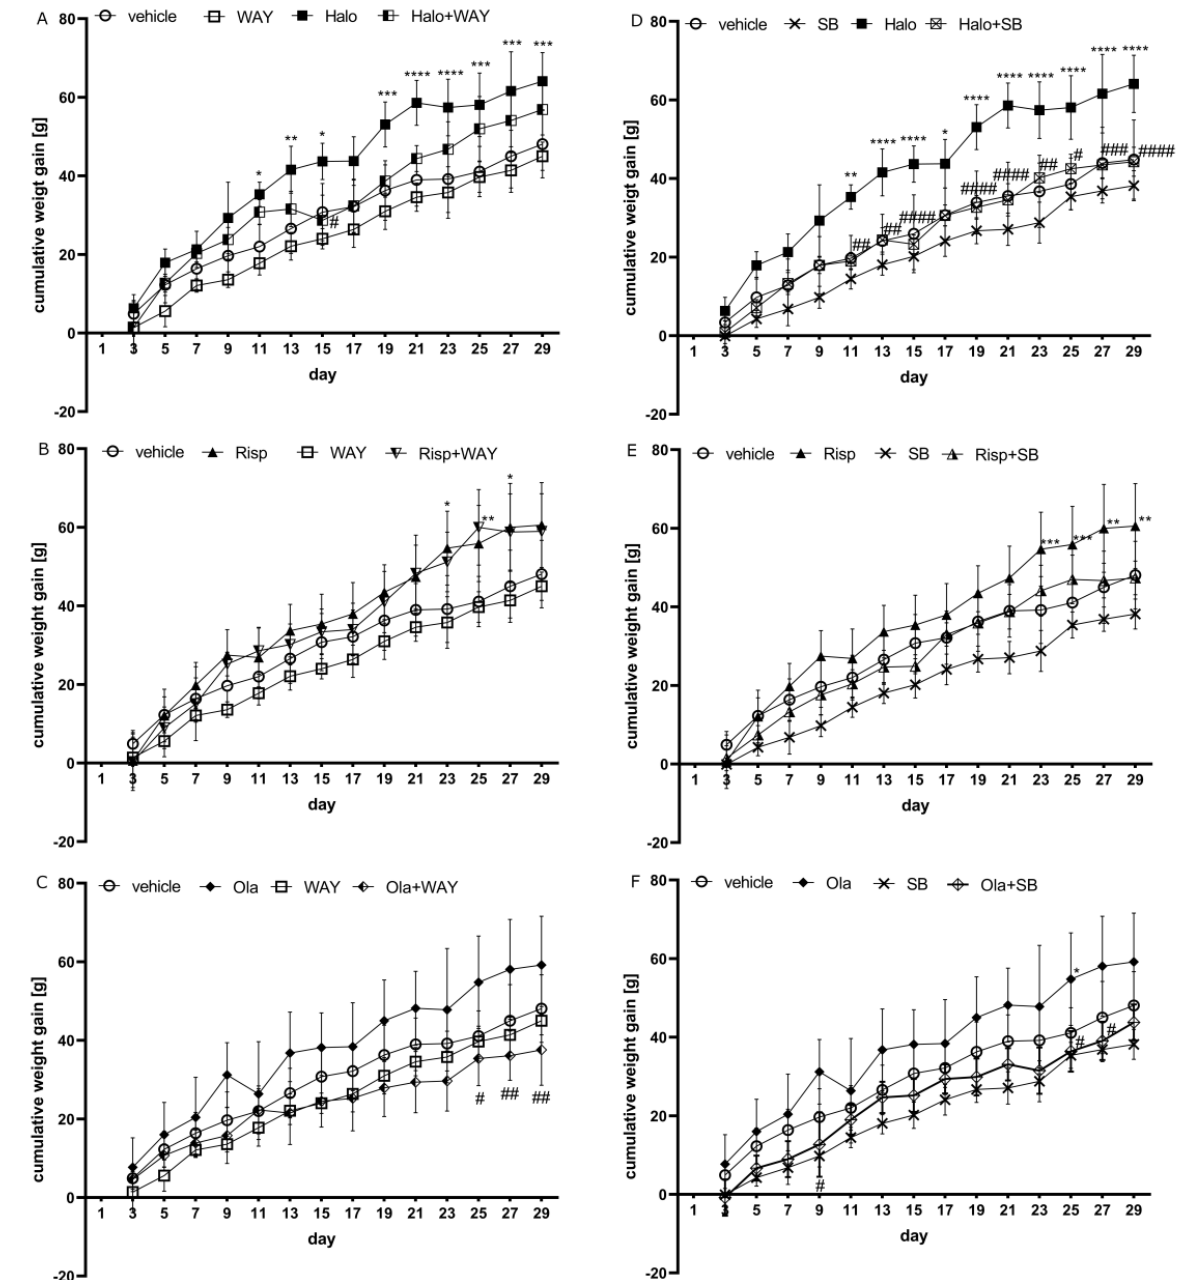
Figure 1. Effects of haloperidol, risperidone, olanzapine, WAY-181187 ( A – C ), and SB-742457 ( D – F ), administered alone and in combinations, on weight gain in rats. The results are presented as mean ± SEM ; n = 9 – 10. * p < 0.05, ** p < 0.01, *** p < 0.001, **** p < 0.0001 versus the respective vehicle-treated group; # p < 0.05, ## p < 0.01, ### p < 0.001, #### p < 0.0001 versus the respective APD-treated group (two-way repeated measures of ANOVA followed by Bonferroni’s post hoc test). Halo, haloperidol 0.5 mg/kg; Risp, risperidone 0.5 mg/kg; Ola, olanzapine 5 mg/kg; WAY, WAY-181187 3 mg/kg; SB, SB-742457 3 mg/kg.